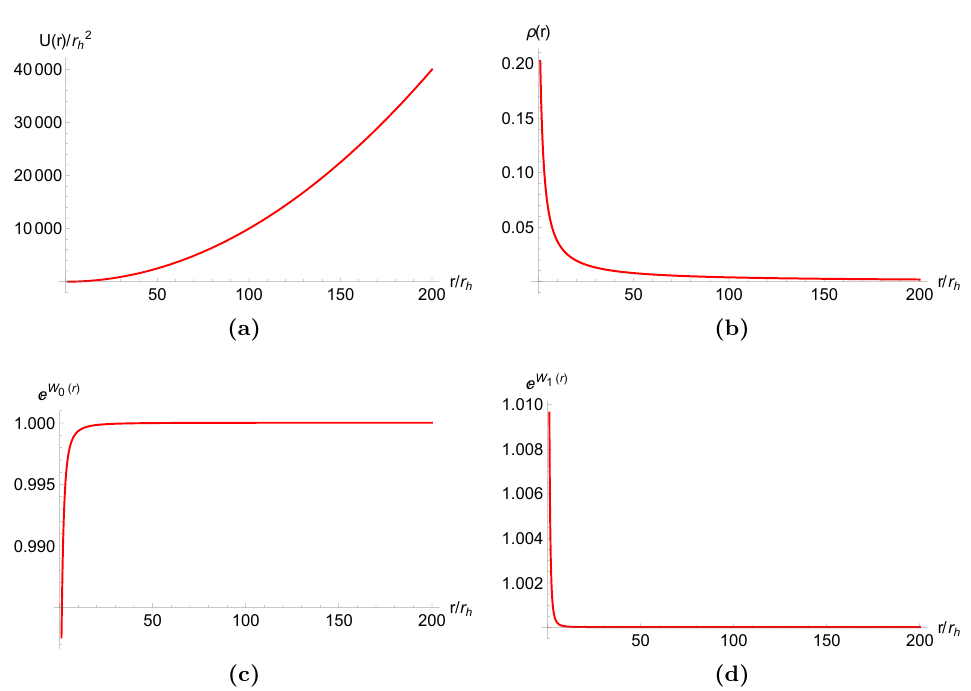
Figure 1. A numerical solution of the black branes with k = 0 : 8 r h , (cid:26) h = 0 : 2, w 0 = (cid:0) 0 : 0176 and w 1 = 0 :